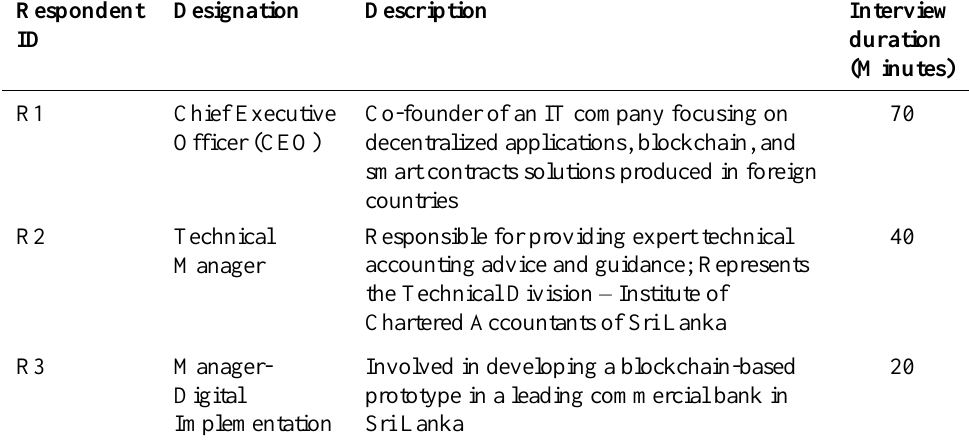
Table 1: Interviewee Details